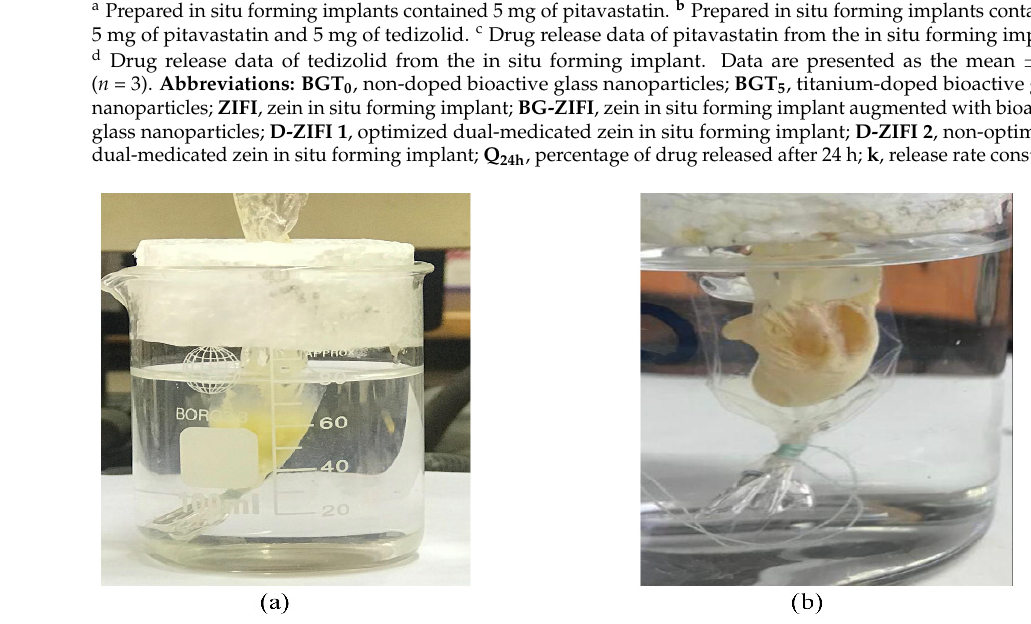
Figure 1. Brief representation of solidification time test; ( a ) during the solidification of the in situ forming implant and ( b ) after the solidification of the